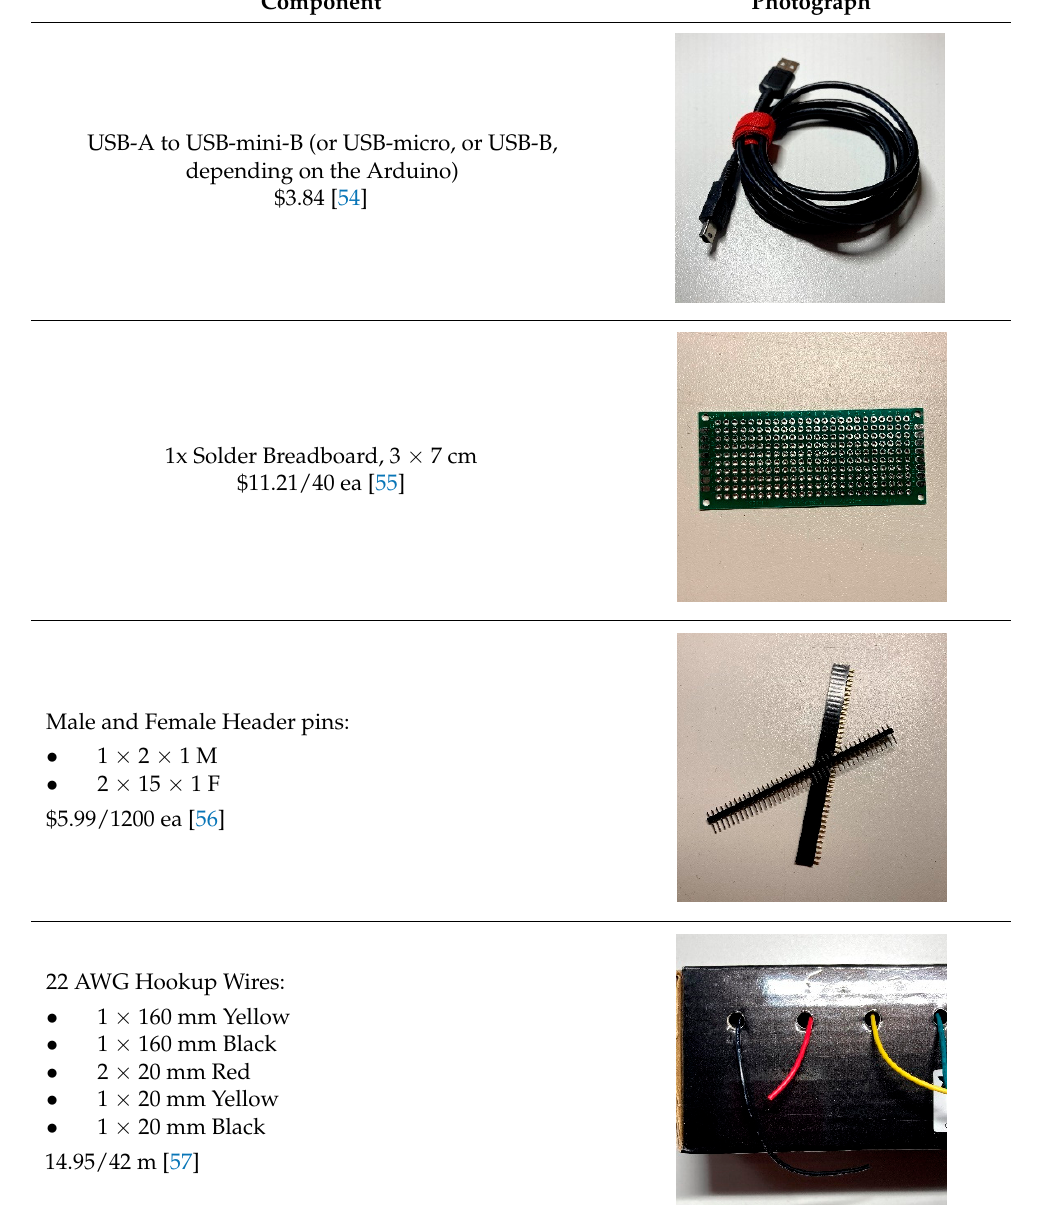
Table A1. Cont. Component